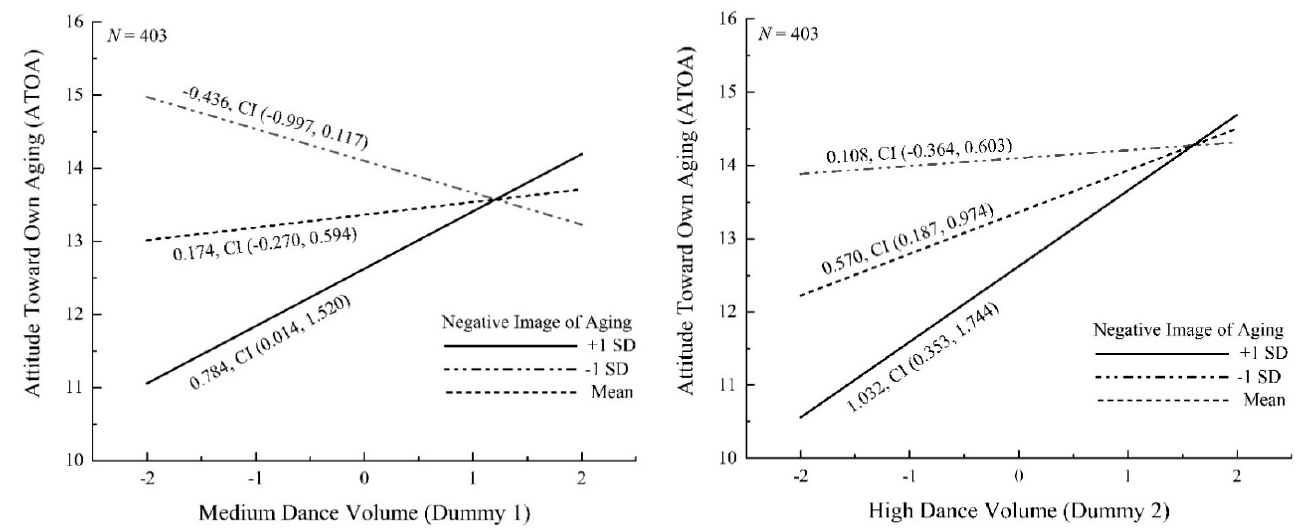
Figure 3. Conditional effects (simple slopes) of dance duration on ATOA at various values of negative IOA (mean, plus, and minus one standard deviation from the mean) for Dummy 1 ( left ) and for Dummy 2 ( right ).